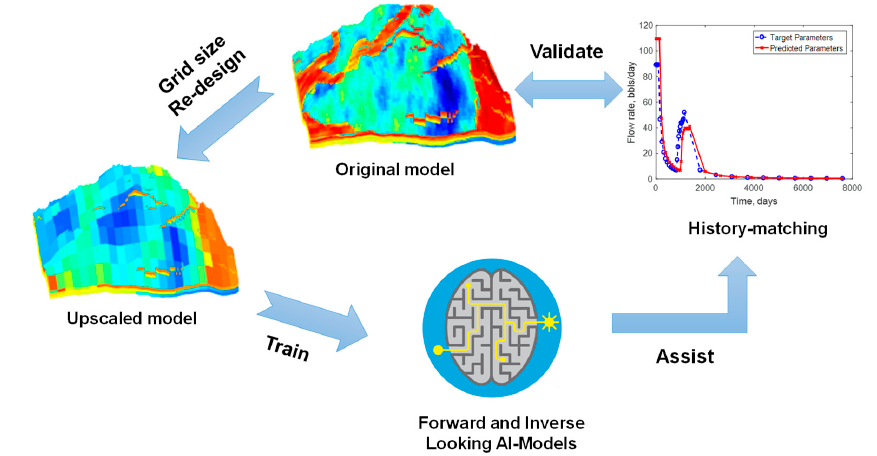
Figure 3. Artificial-intelligence assisted history-matching workflow: Developments of AI-models.